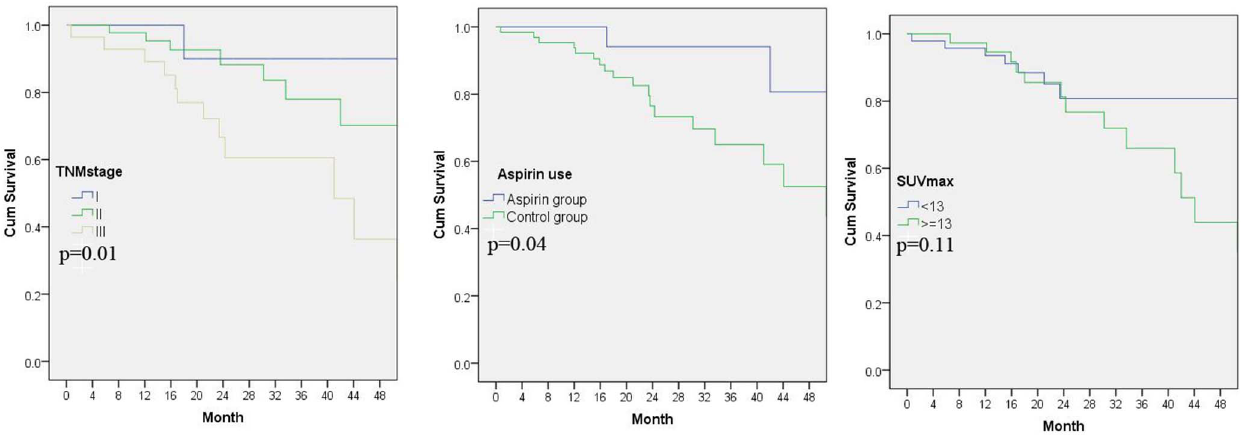
Figure 1. Progression-free survival as differentiated by TNM stage, history of aspirin use and SUVmax, respectively. A: PFS differences between TNM categories, p=0.01. B: PFS differences between aspirin categories, p=0.04; C: PFS differences between SUV max categories, p=0.11.